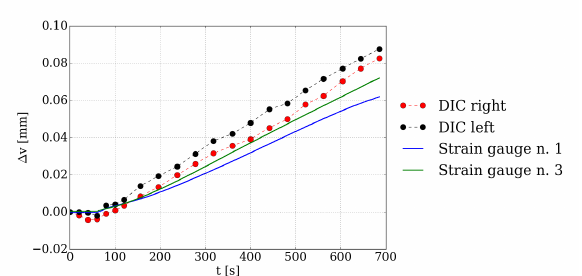
Figure 15: Comparison between the vertical displacements ob- tained by the DIC method and the strain gauges measurements for sample n. 3.